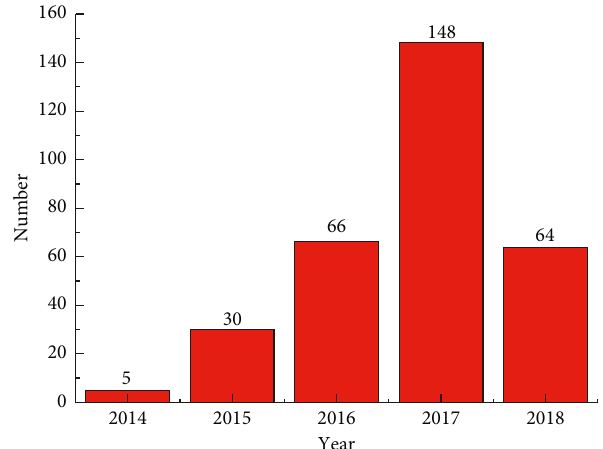
Figure 1: The number of water environment treatment PPP projects undertaken in the past five years. Note. The data of this paper are from the PPP center project management database of the Ministry of Finance, and the statistical time is as of October 11,